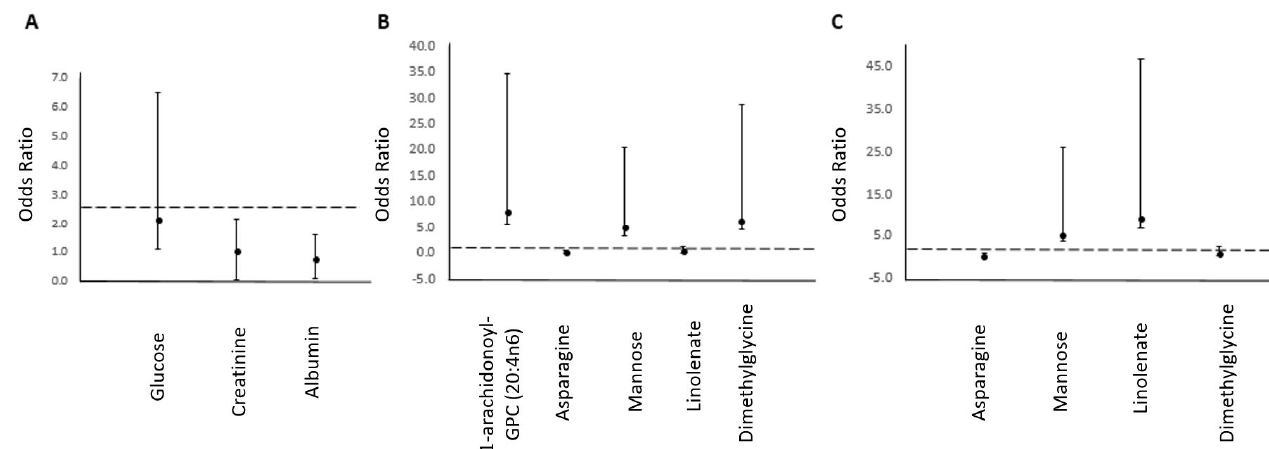
Figure 1. Individual metabolite odds ratios (95% CI) for ( A ) three classical traits (glucose, creatinine and albumin), ( B ) five CHD metabolites in the discovery cohort (1-arachidoniolyl 1-arachidonoyl-glycerylphosphorylcholine (GPC), asparagine, mannose, linolenate and dimethylglycine) and ( C ) four CHD metabolites in replication cohort (asparagine, mannose, linolenate and dimethylglycine).